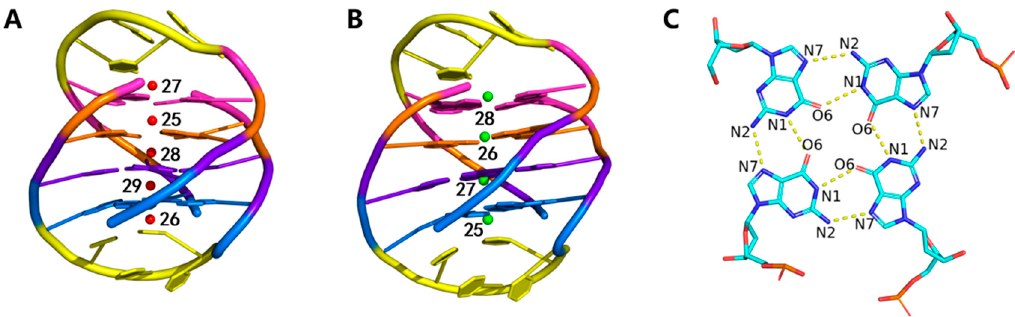
Figure 1. Two DNA GQs used in this study. They share the same sequence (GGGGTTTTGGGG) 2 and 3D structure but use different metal ions as cofactors. Diagonal loops, tetrad 1, tetrad 2, tetrad 3, and tetrad 4 are colored by yellow, magenta, orange, purple, and blue, respectively. ( A ) K-GQ. K + ions are colored in red. ( B ) Na-GQ. Na + ions are colored in green. ( C ) Hoogsteen hydrogen bonds in tetrad 2.